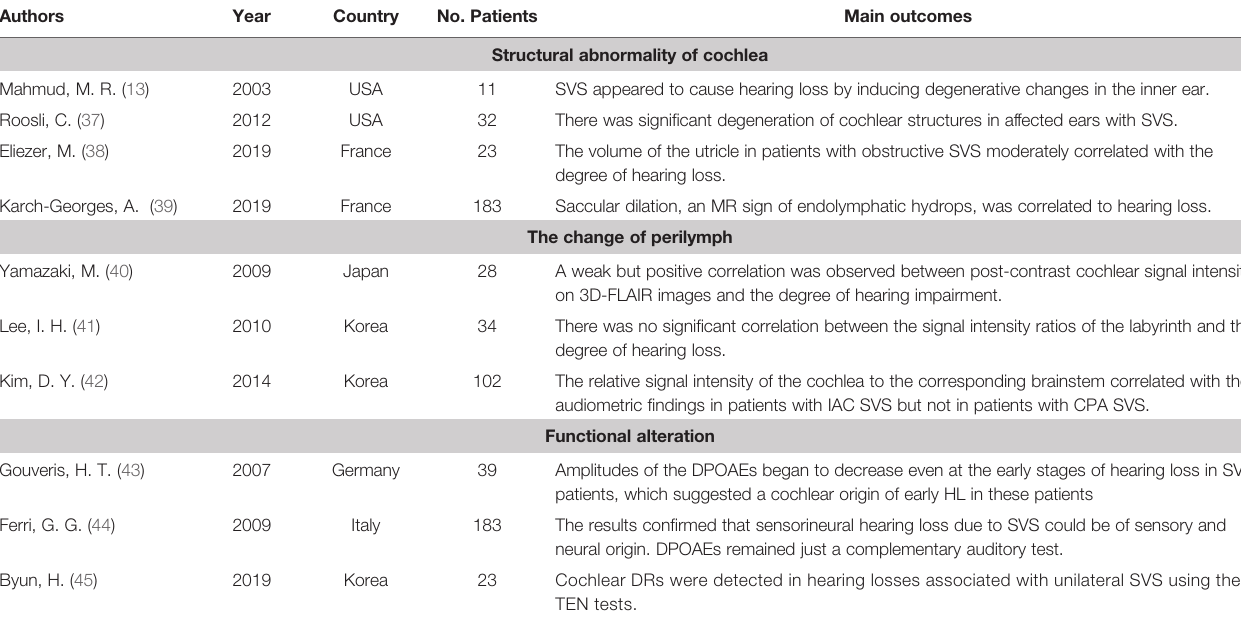
TABLE 4 | The summarization of literature regarding cochlear dysfunction in SVS-associated hearing